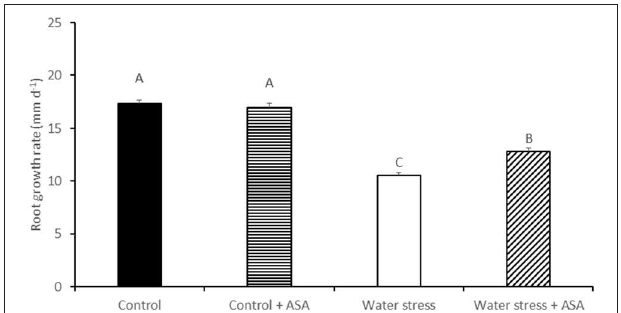
FIGURE 1 | Root growth rate of tall fescue exposed to non-stress control, non-stress control with ascorbic acid (ASA) treatment, water stress, and water stress with ASA treatment. The data represent mean ± SE ( n = 15 plants). Columns marked with the same letter are not significantly different at p < 0.05 .